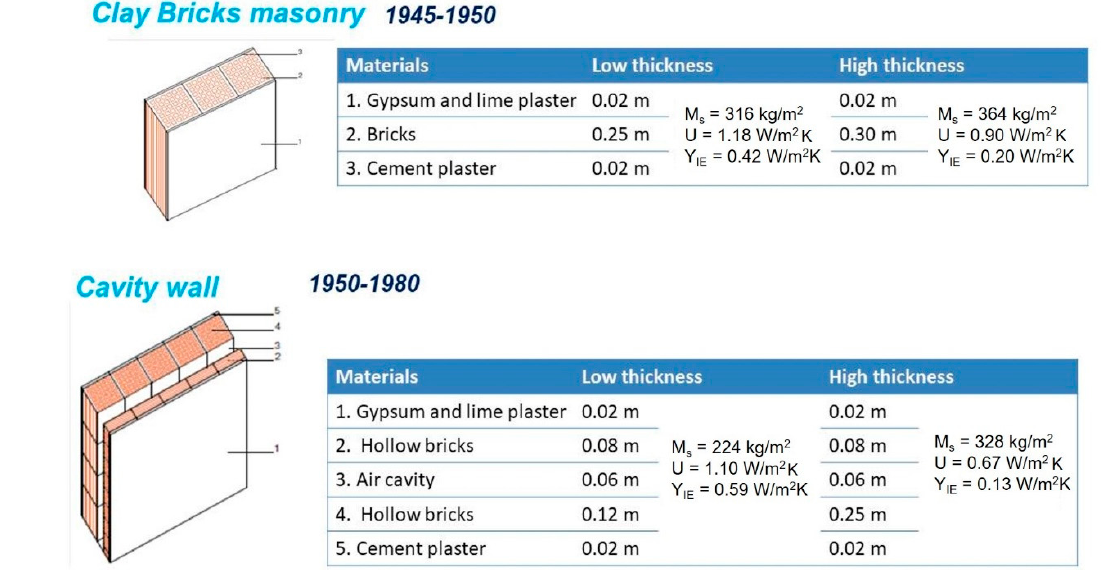
Figure 3. Reference wall in case of Campania region.